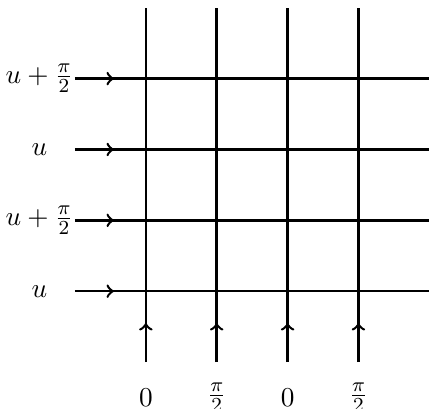
Figure 3 . The spectral parameters on the lattice of the staggered six-vertex model.